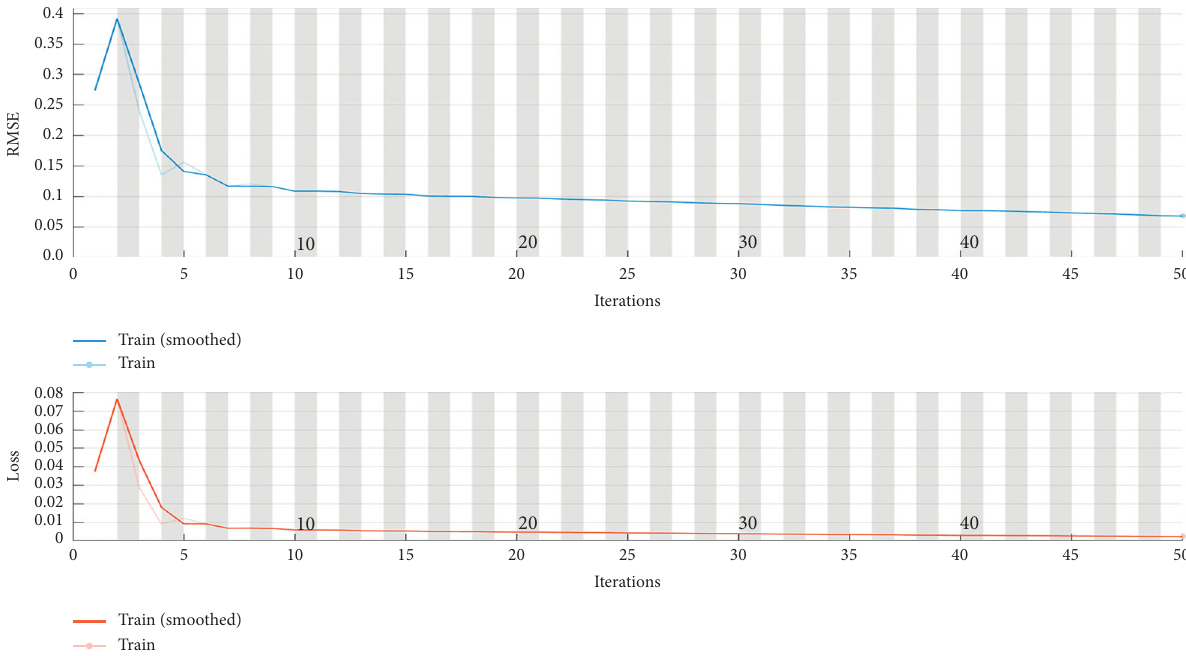
Figure 7: The RMSE and loss function values on the training database of